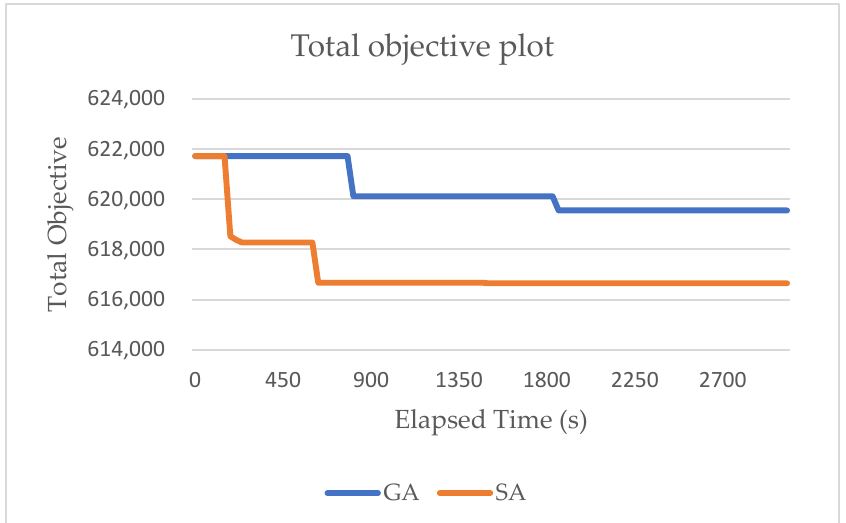
Figure 5. Convergency analysis of SA during the searching process.